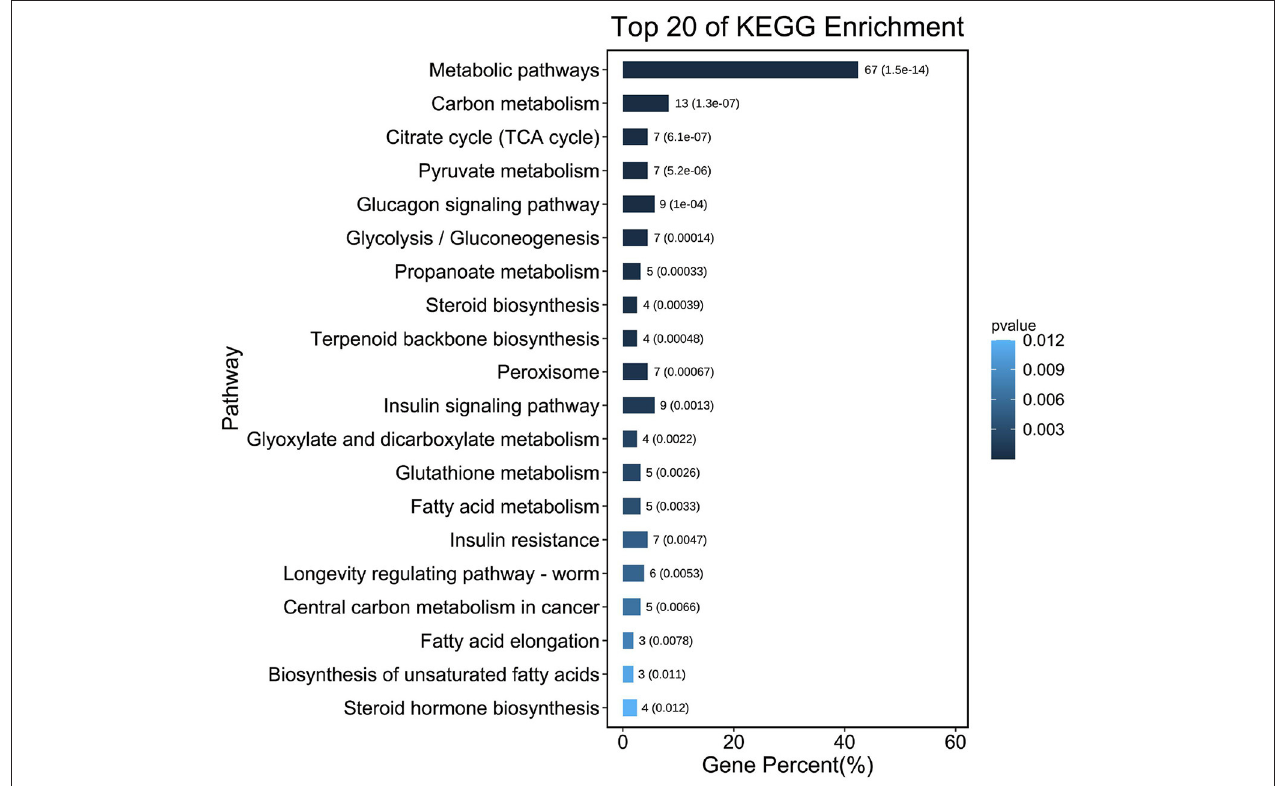
FIGURE 3 | The column diagrams of top 20 Kyoto encyclopedia of genes and genomes (KEGG)